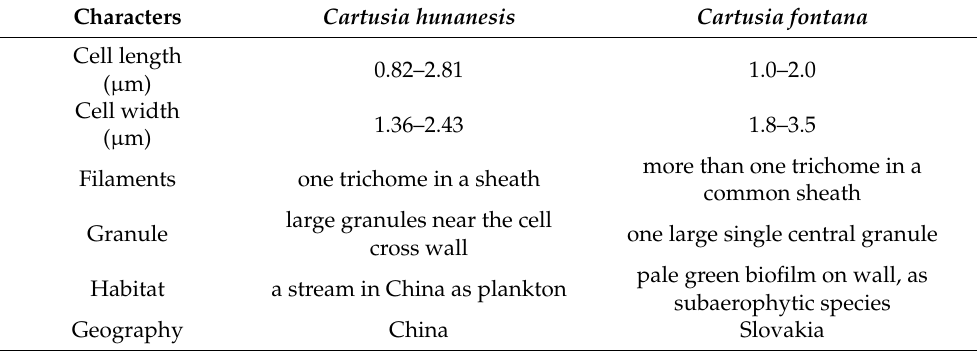
Figure 2. TEM micrographs of Cartusia hunanesis ZJJ02. ( A ) Cross section of a cell in its surrounding sheath. ( B ) Longitudinal section of a filament. Scale bar = 0.5 µm. S = sheath; t = thylakoids. The thylakoids are arranged roughly parallel in a parietal position. Table 2. Comparison of the characteristics of Cartusia hunanesis and Cartusia fontana